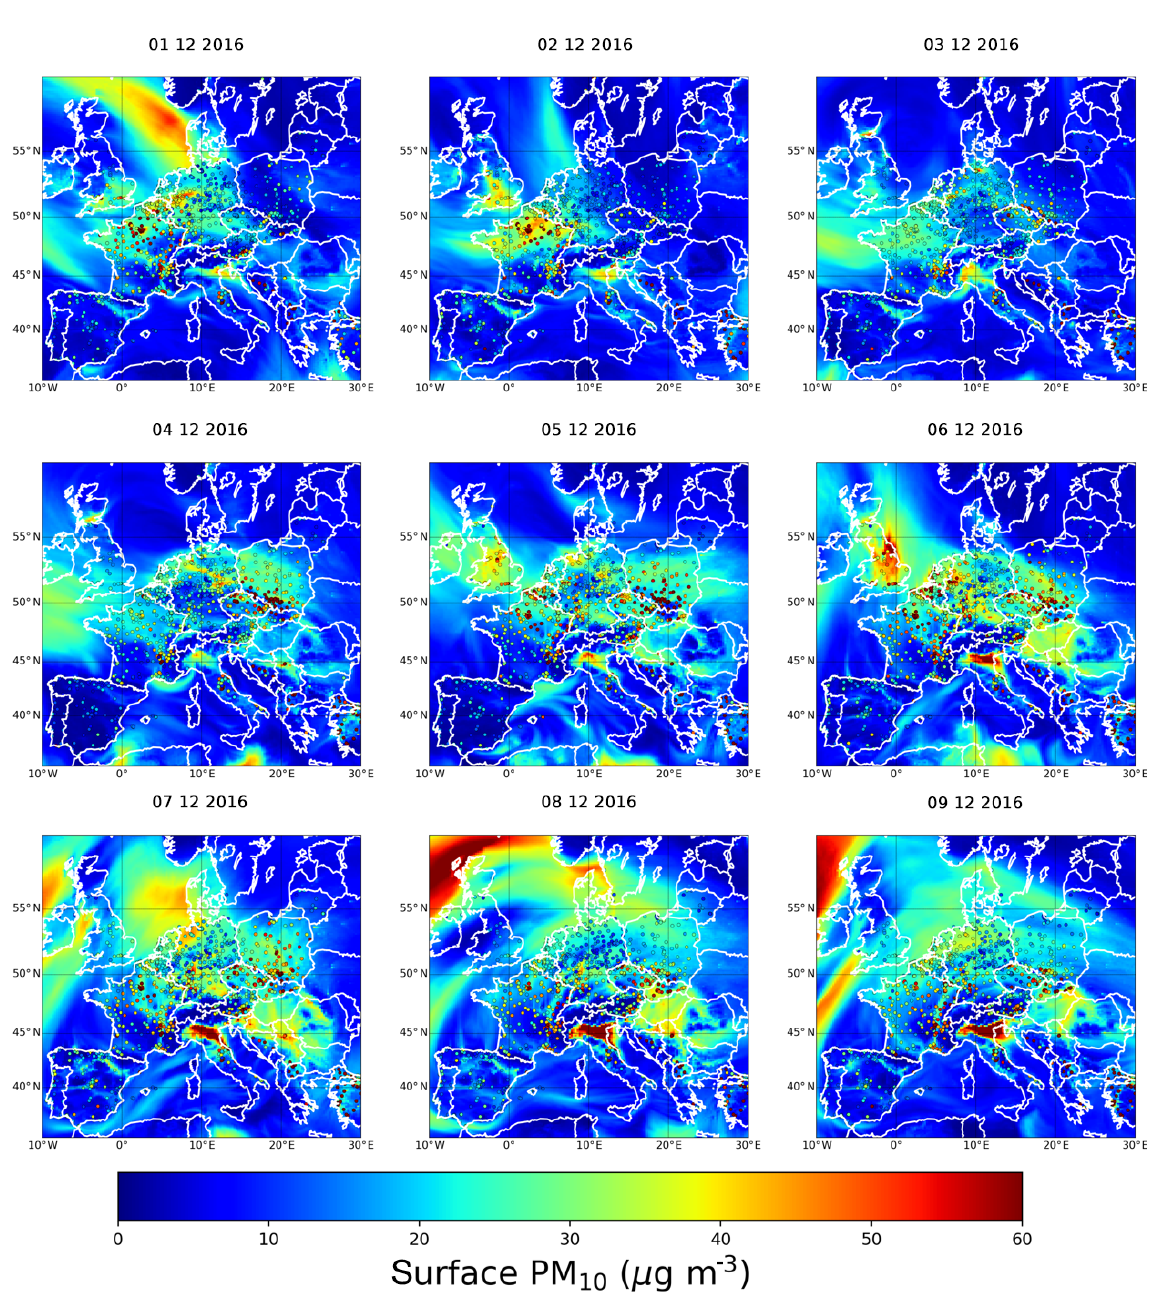
Figure 2. Daily surface PM 10 concentration, in micrograms per cubic metre, over Europe predicted by the EMEP model from 1 to 9 Decem- ber 2016. The coloured dots correspond to the daily mean of AirBase stations (rural and urban